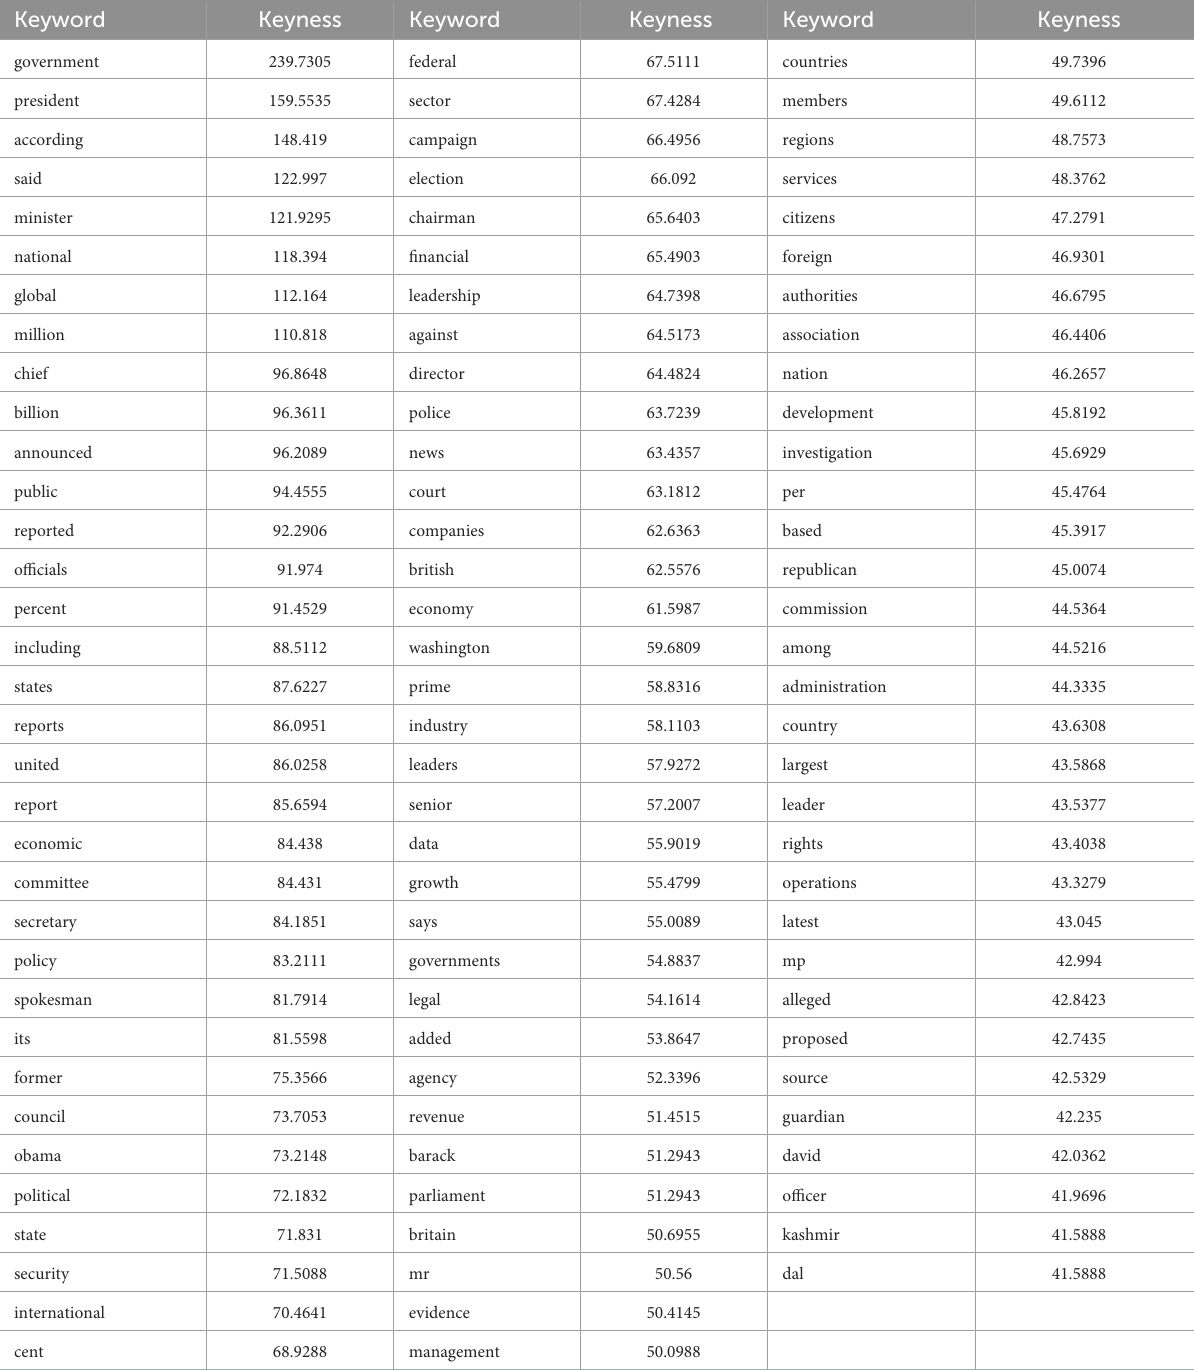
TABLE 5 Top 100 keywords for news in descending order estimated with the